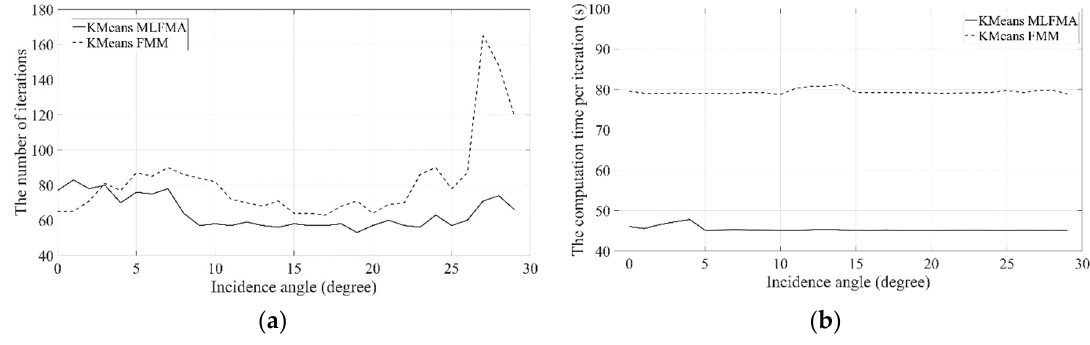
Figure 7. Comparisons between the previous and proposed method for a 3 m radius sphere CAD model: ( a ) the number of iterations as a function of the incidence angle; ( b ) the computation time per iteration as a function of the incidence angle.